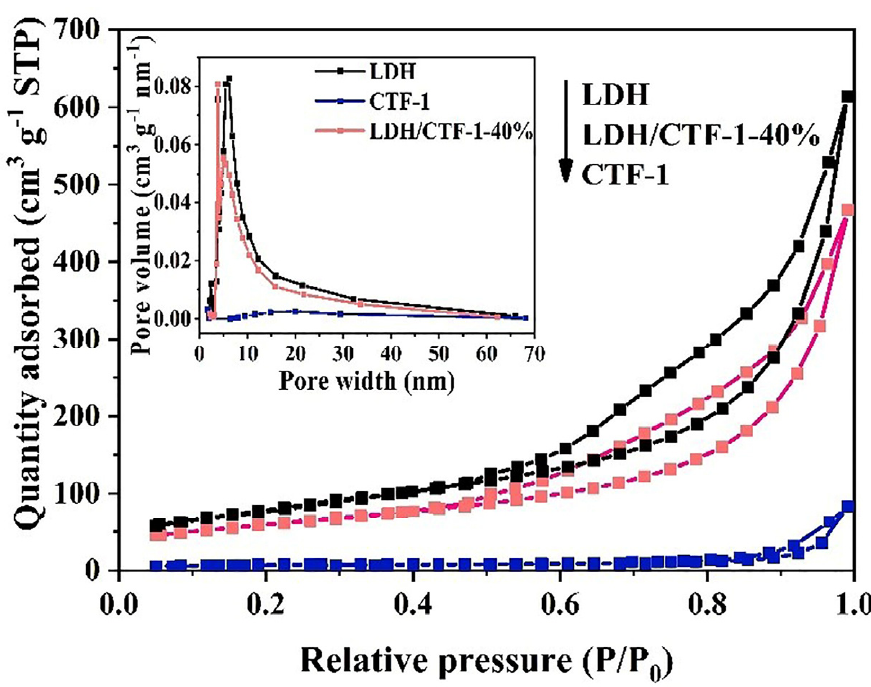
Figure 5. Nitrogen adsorption–desorption isotherms and relevant pore size distribution curves (inset) of LDH, CTF-1, and the LDH/CTF-1-40% samples. Table 1. BET surface area and pore volume of LDH, CTF-1, and the LDH/CTF-1-40% samples.